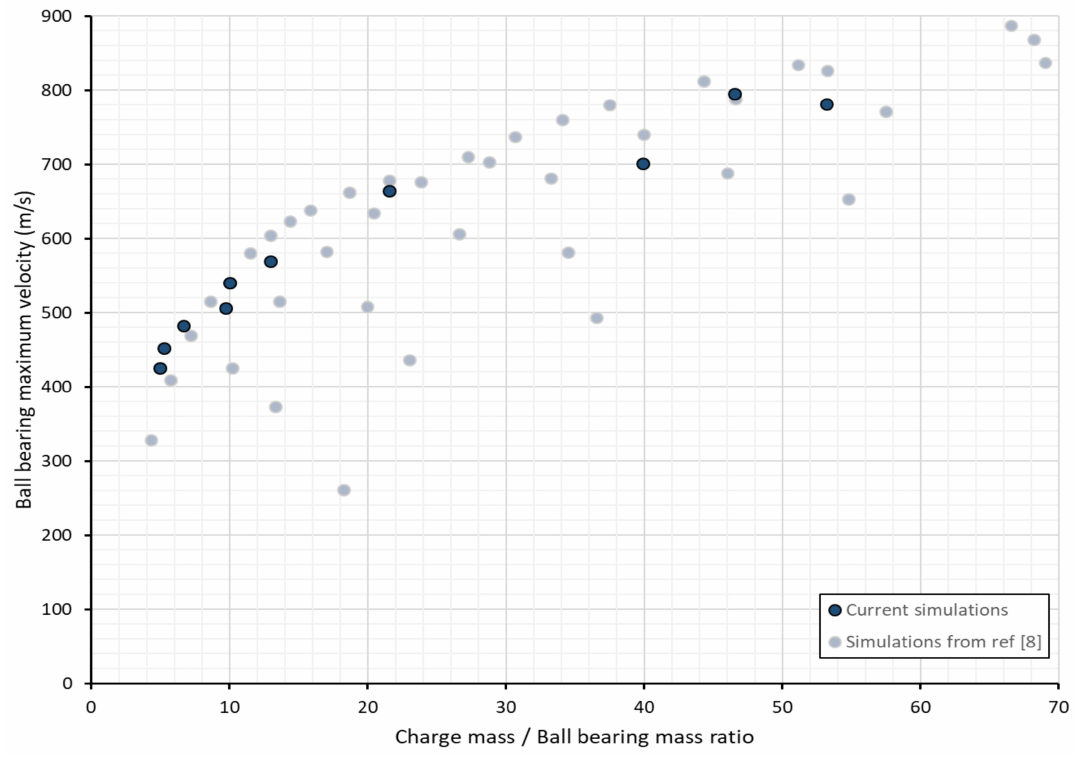
Figure 12. Graph of maximum ball bearing velocity versus charge mass/ball bearing mass